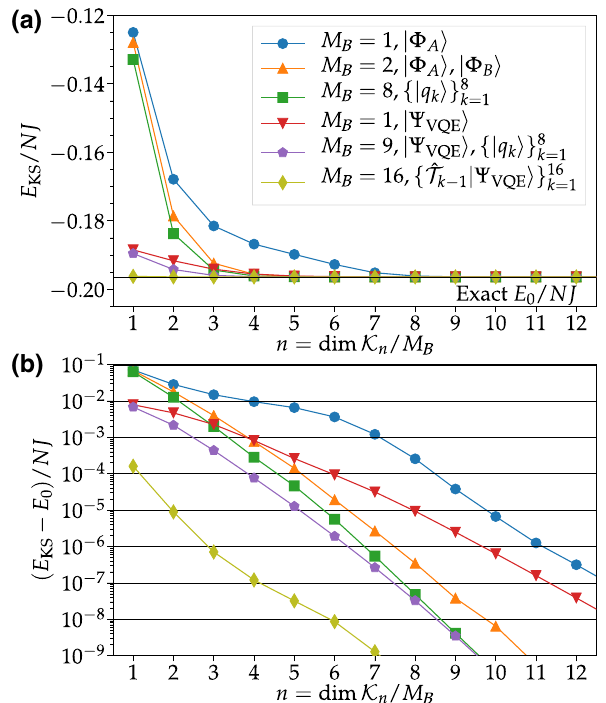
FIG. 5. (a) Ground-state energy E KS for the spin-1/2 Heisen- berg model on an N = 16 qubit ring as a function of the dimension of the Krylov subspace K n per block size M B , n = dim K n / M B , with various sets of the reference states. The hor- izontal line indicates the exact ground-state energy E 0 . The results are obtained with (cid:3) τ J = 0.05, r = 1, m = 1, and p = 3. (b) Same as (a) but a semilog plot of the energy difference E KS − E 0 as a function of n . (cid:3) , | Y (cid:3) , zero for the reference states | X AFM 1(2) AFM 1(2)